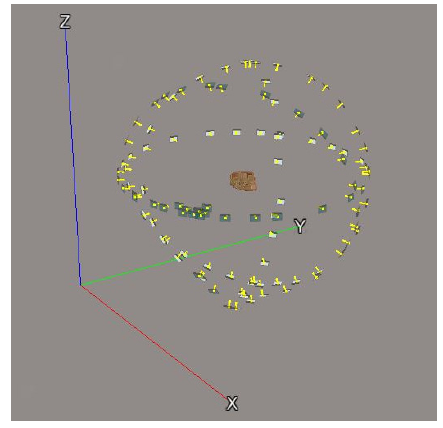
Figure 8. ContextCapture image orientation of the fragment with Centauromachia scene.